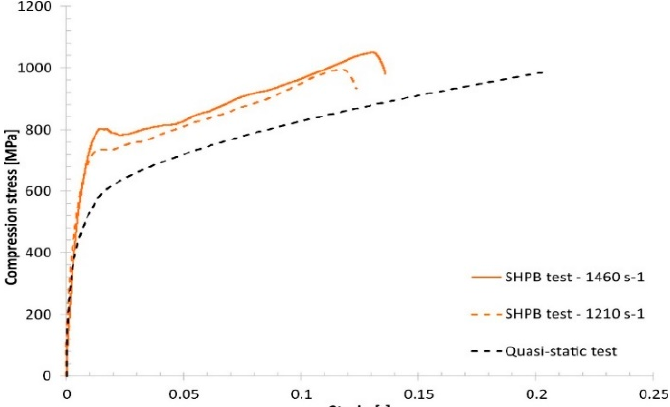
Figure 16. Comparison of the dynamic and quasi-static uniaxial compression test results obtained for specimen No. 01.